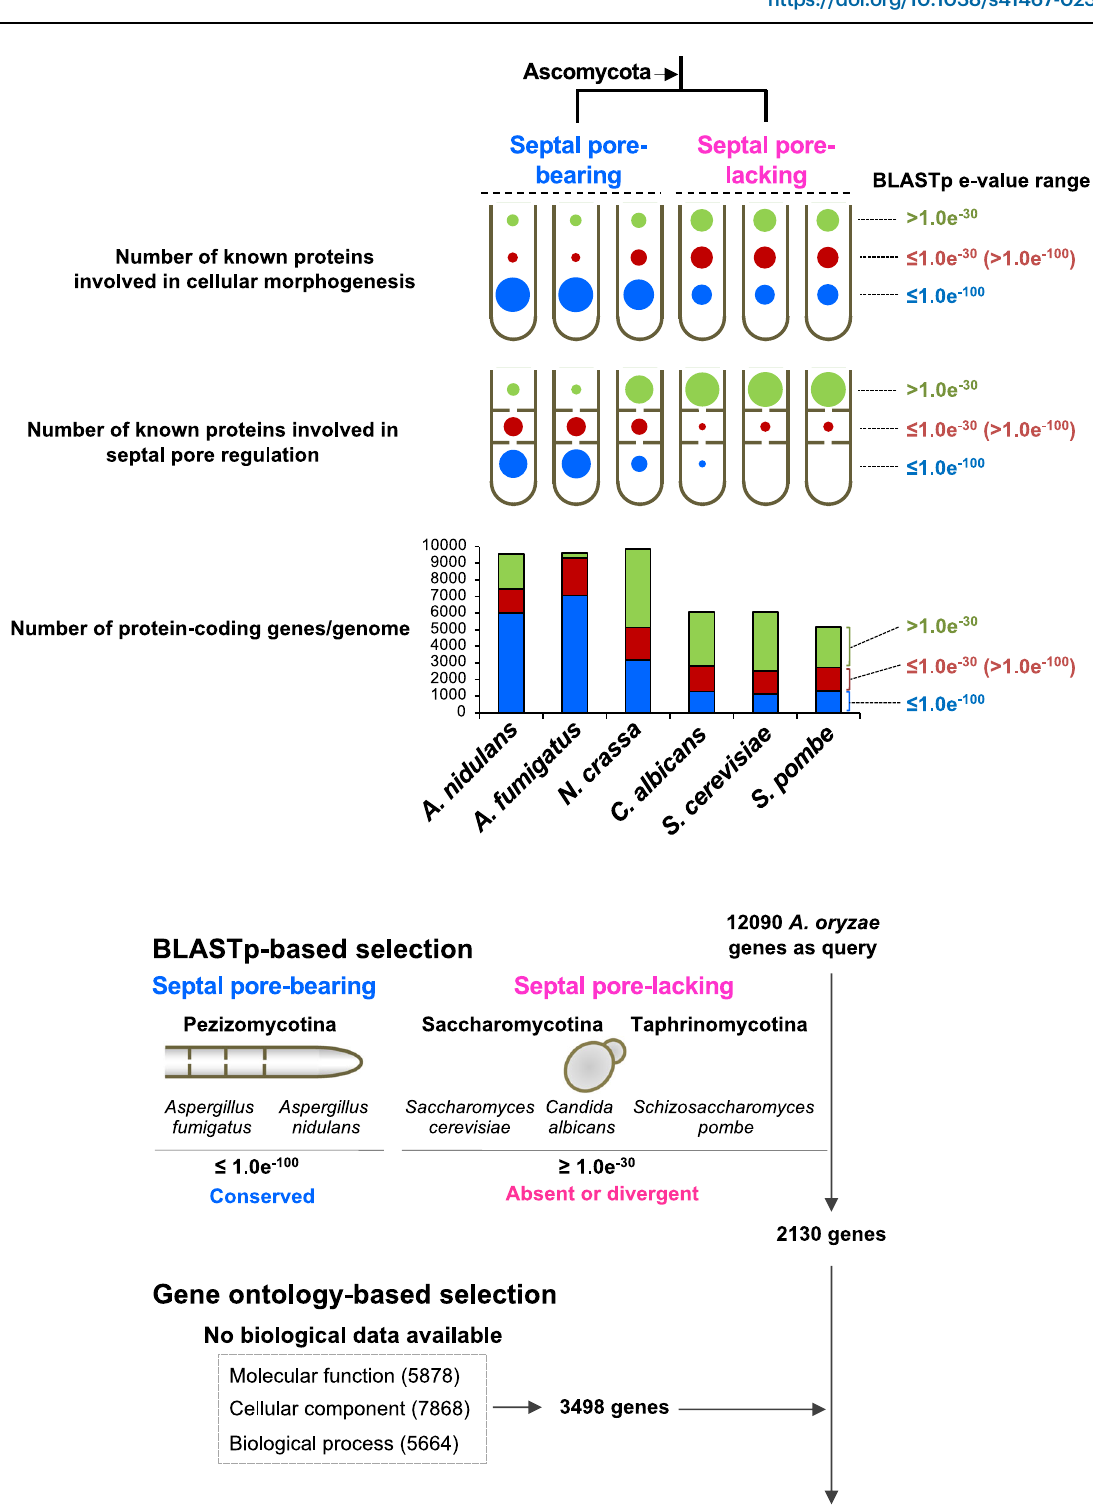
Fig. 1 | Strategy for selecting candidate septal pore proteins. a BLASTp-based genomic comparison among the septal pore-bearing and -lacking ascomycetes. Upper cartoons of hyphae show the hyphal morphology, and lower cartoons of hyphae with perforated septa indicate the septal pore and its regulation. The bubble size is proportional to the number of known proteins involved in cellular morphogenesis (upper bubble chart, Supplementary Data 1a) and septal pore